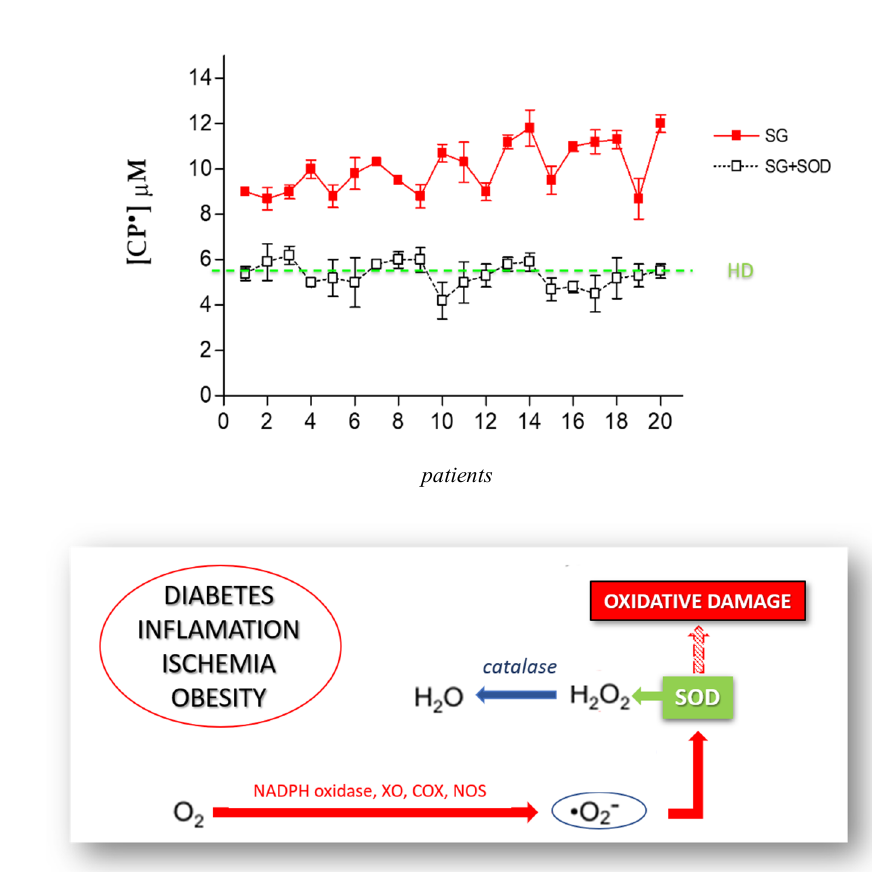
Figure 4. ( A ) EPR-spin probing analysis of the obese patients’ blood (SG), before (red squares) and after (white squares) the in vitro treatment with SOD. The green line represents the mean value of the